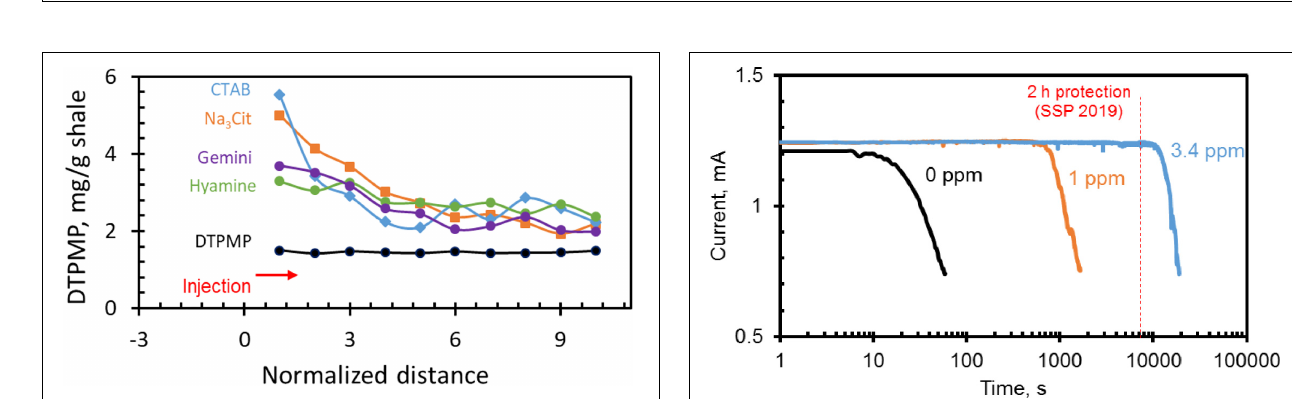
FIGURE 10 | The calculated logarithm of ion activity (pIP) during squeeze test, 70 ◦ C, 1000 ppm Ca 2 + .